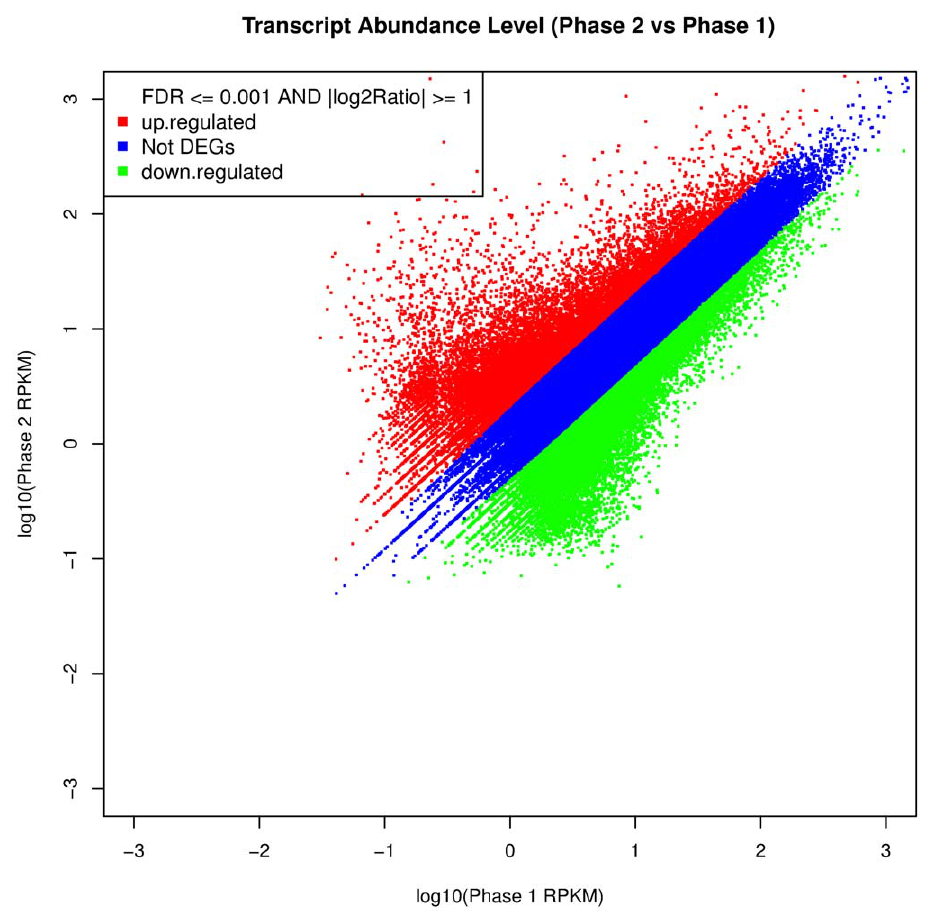
Figure 3. Changes of transcript abundance levels between phase 1 and phase 2.